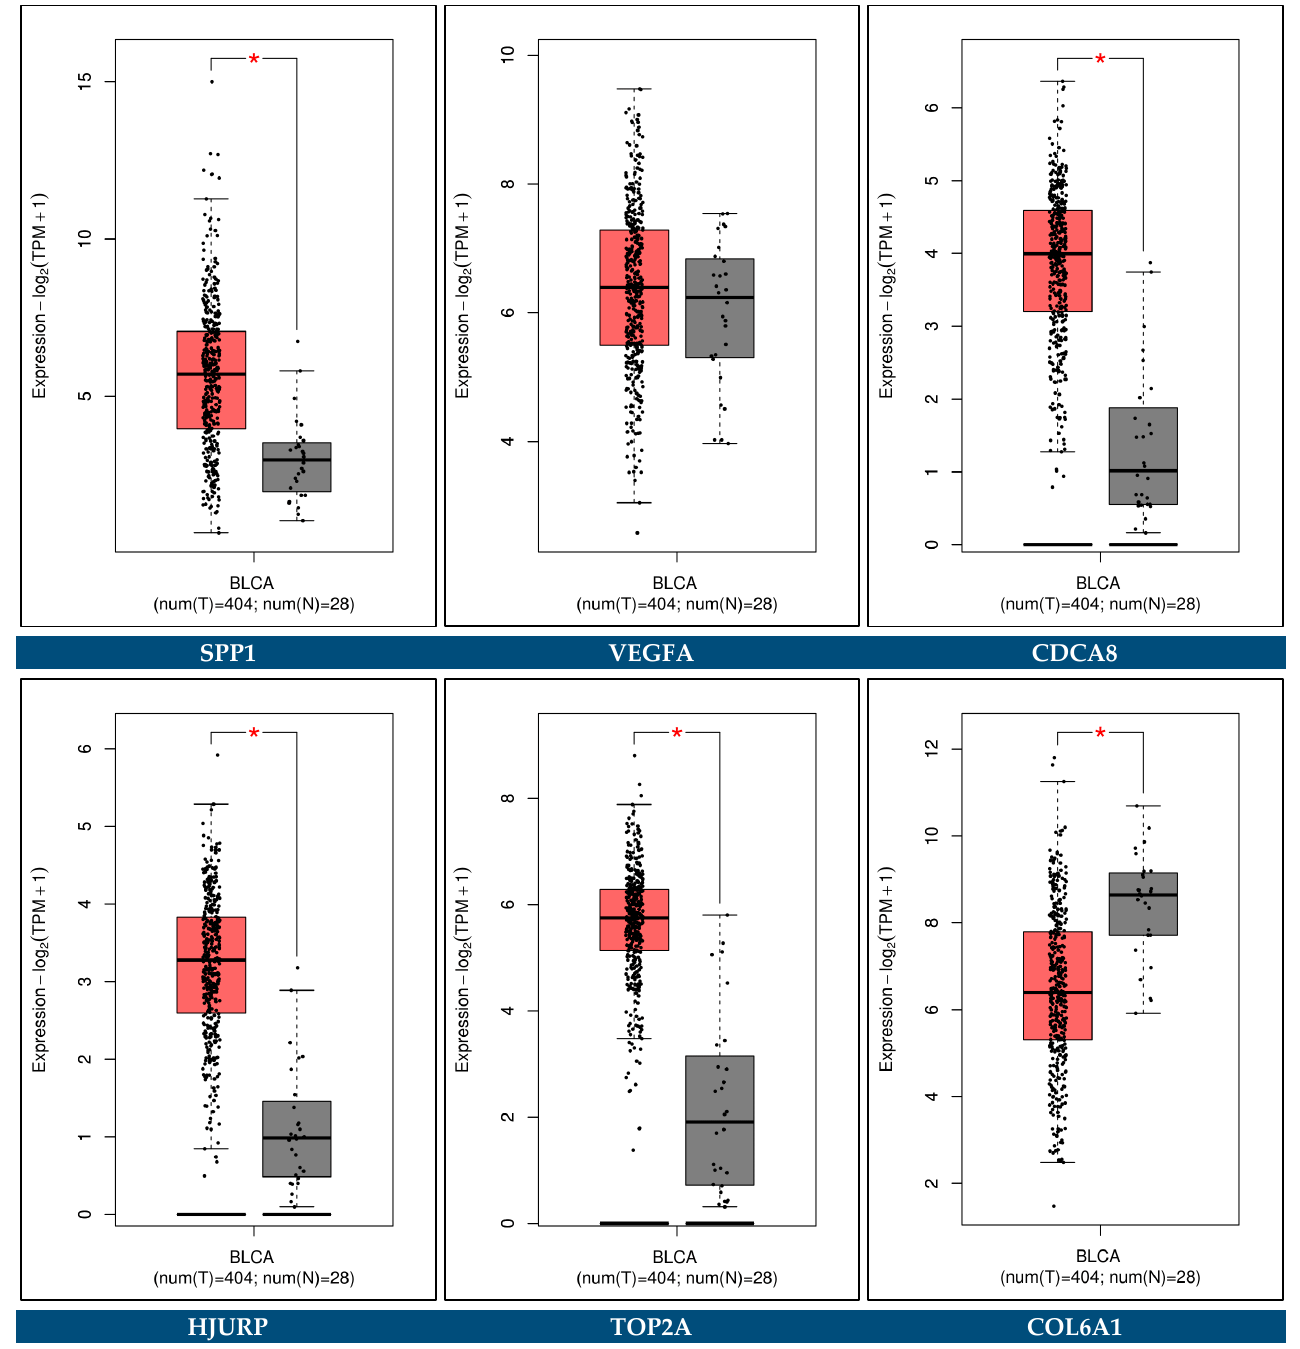
Figure 25. The gene expression level analysis of the nine key biomarkers in BCa patients, generated using the GEPIA2 platform. The red boxes represent the mRNA expression levels in BCa tissues and the gray boxes represent the expression levels in control bladder tissues from patients of the TCGA- BCa and GTEx cohorts. * indicates statistical significance applying p -value < 0.05 and |log 2 FC| < 1 as cut-off criteria (BLCA: bladder cancer, TPM: transcript count per million).